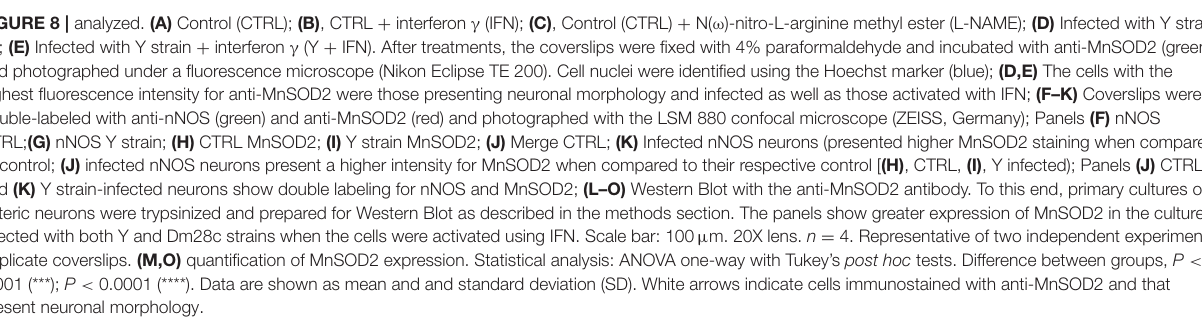
FIGURE 8 | analyzed. (A) Control (CTRL); (B) , CTRL + interferon γ (IFN); (C) , Control (CTRL) + N( ω )-nitro-L-arginine methyl ester (L-NAME); (D) Infected with Y strain (Y); (E) Infected with Y strain + interferon γ (Y + IFN). After treatments, the coverslips were fixed with 4% paraformaldehyde and incubated with anti-MnSOD2 (green) and photographed under a fluorescence microscope (Nikon Eclipse TE 200). Cell nuclei were identified using the Hoechst marker (blue); (D,E) The cells with the highest fluorescence intensity for anti-MnSOD2 were those presenting neuronal morphology and infected as well as those activated with IFN; (F–K) Coverslips were double-labeled with anti-nNOS (green) and anti-MnSOD2 (red) and photographed with the LSM 880 confocal microscope (ZEISS, Germany); Panels (F) nNOS CTRL; (G) nNOS Y strain; (H) CTRL MnSOD2; (I) Y strain MnSOD2; (J) Merge CTRL; (K) Infected nNOS neurons (presented higher MnSOD2 staining when compared to control; (J) infected nNOS neurons present a higher intensity for MnSOD2 when compared to their respective control [ (H) , CTRL, (I) , Y infected); Panels (J) CTRL and (K) Y strain-infected neurons show double labeling for nNOS and MnSOD2; (L–O) Western Blot with the anti-MnSOD2 antibody. To this end, primary cultures of enteric neurons were trypsinized and prepared for Western Blot as described in the methods section. The panels show greater expression of MnSOD2 in the cultures infected with both Y and Dm28c strains when the cells were activated using IFN. Scale bar: 100 µ m. 20X lens. n = 4. Representative of two independent experiments duplicate coverslips. (M,O) quantification of MnSOD2 expression. Statistical analysis: ANOVA one-way with Tukey’s post hoc tests. Difference between groups, P < 0.001 (***); P < 0.0001 (****). Data are shown as mean and and standard deviation (SD). White arrows indicate cells immunostained with anti-MnSOD2 and that present neuronal